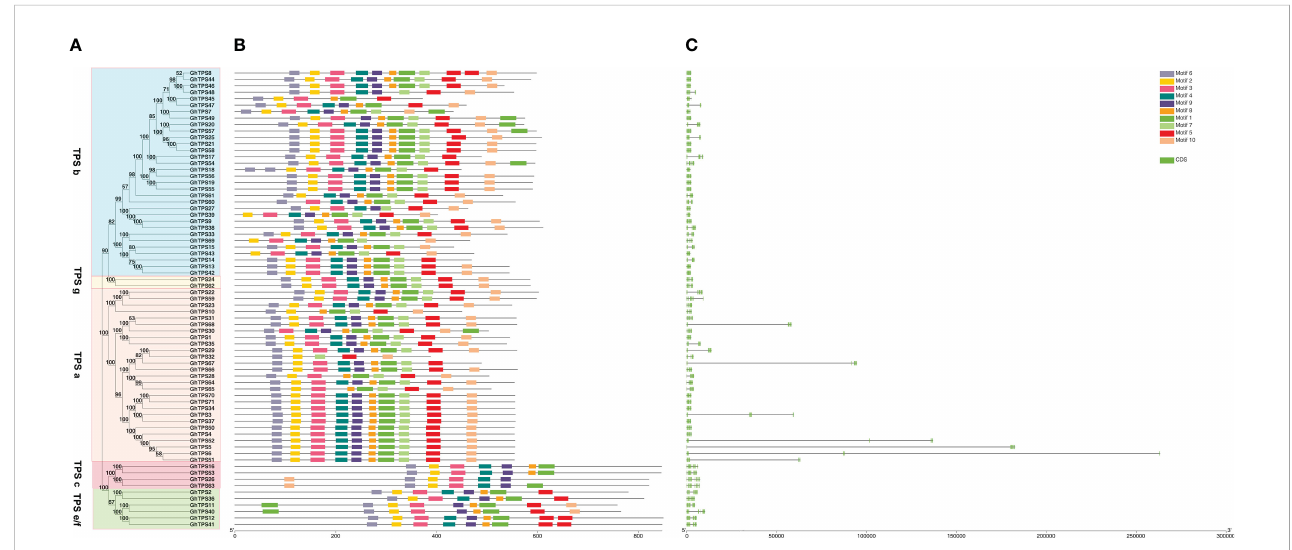
FIGURE 3 Phylogenetic tree - motif - structure of GhTPSs. (A) Phylogenetic tree. (B) Protein motifs. (C) Gene